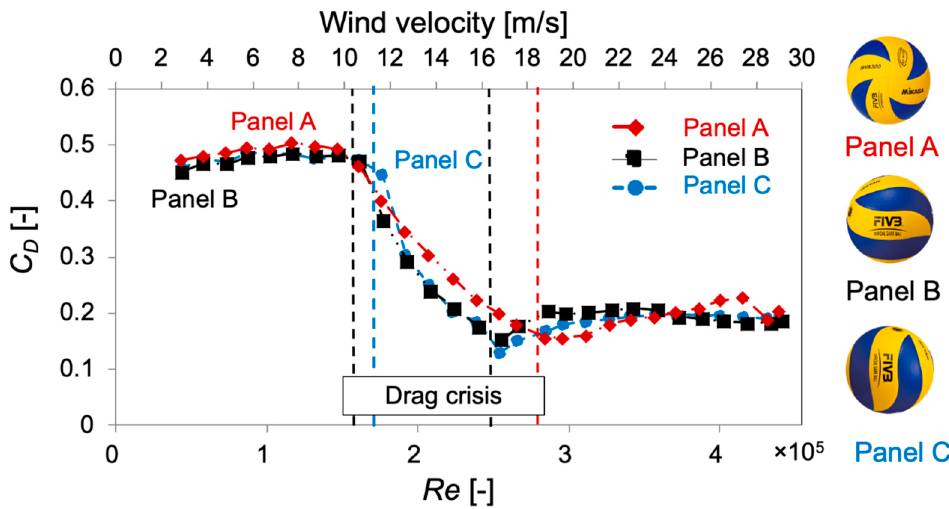
Figure 5. Relationship between Reynolds number and drag coefficient on MVA200.